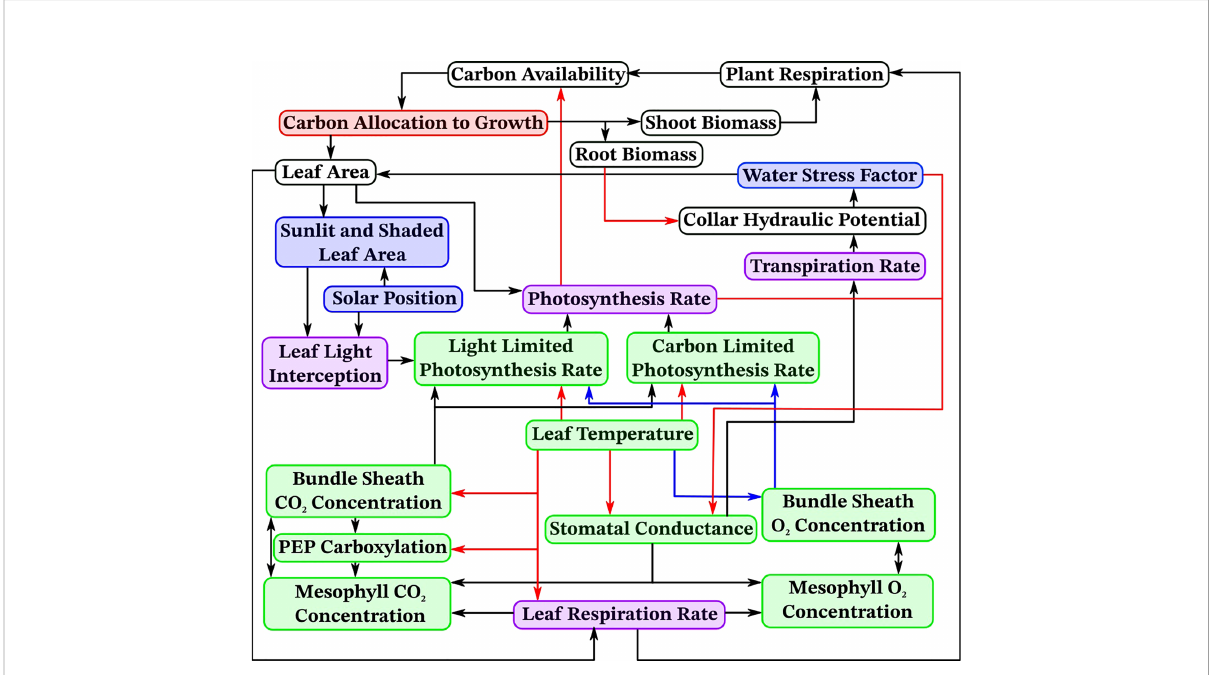
FIGURE 1 An overview of important new models and their dependencies in OpenSimRoot . Arrows point from a variable to variables depending on it, arrow colors are solely for distinguishing between them. White indicates models which were already present and are unchanged, red indicates models which were updated, blue indicates newly added models, green indicates newly added models with separate sunlit and shaded instances and purple indicates already present models which now have separate sunlit and shaded